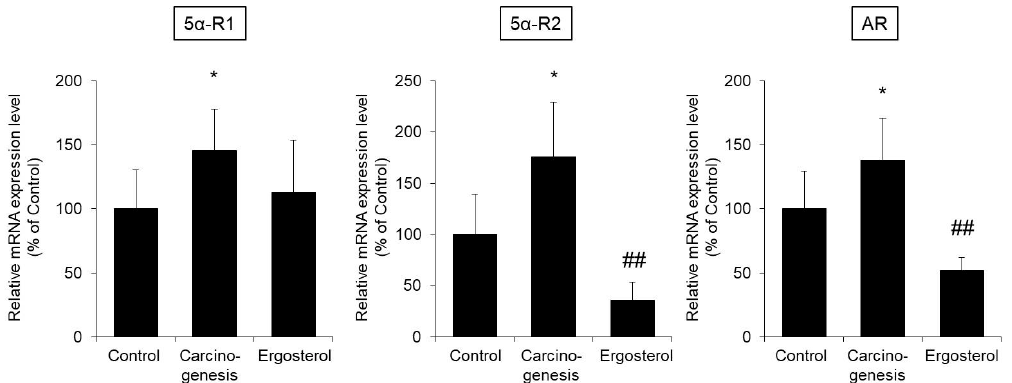
Figure 5. The mRNA expression levels of 5 α -reductase and androgen receptor (AR) in bladder epithelial cells. The bladders were removed from rats in the control, carcinogenesis, and ergosterol-treated groups, and the mRNA expression levels of 5 α -reductase type 1 (5 α -R1), 5 α -reductase type 2 (5 α -R2), and AR were measured using real-time RT-PCR and normalized to those of 18S rRNA. The data are presented as percentages of the mean value in the control group, which was set at 100%. The data show the mean ± SD from five rats per group. Tukey’s test, * p < 0.05 vs. the control group, ## p < 0.01 vs. the carcinogenesis group.